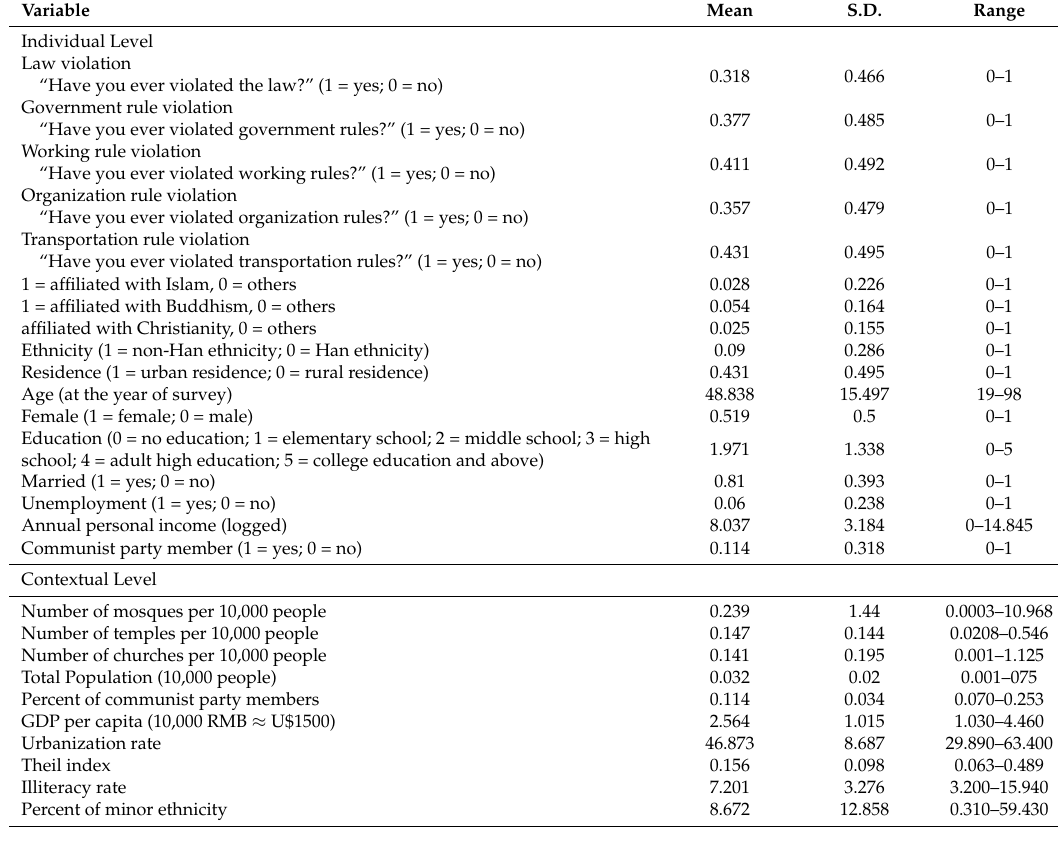
Table 1. Descriptive statistics (individual variables N = 8224 provincial variables N = 25).